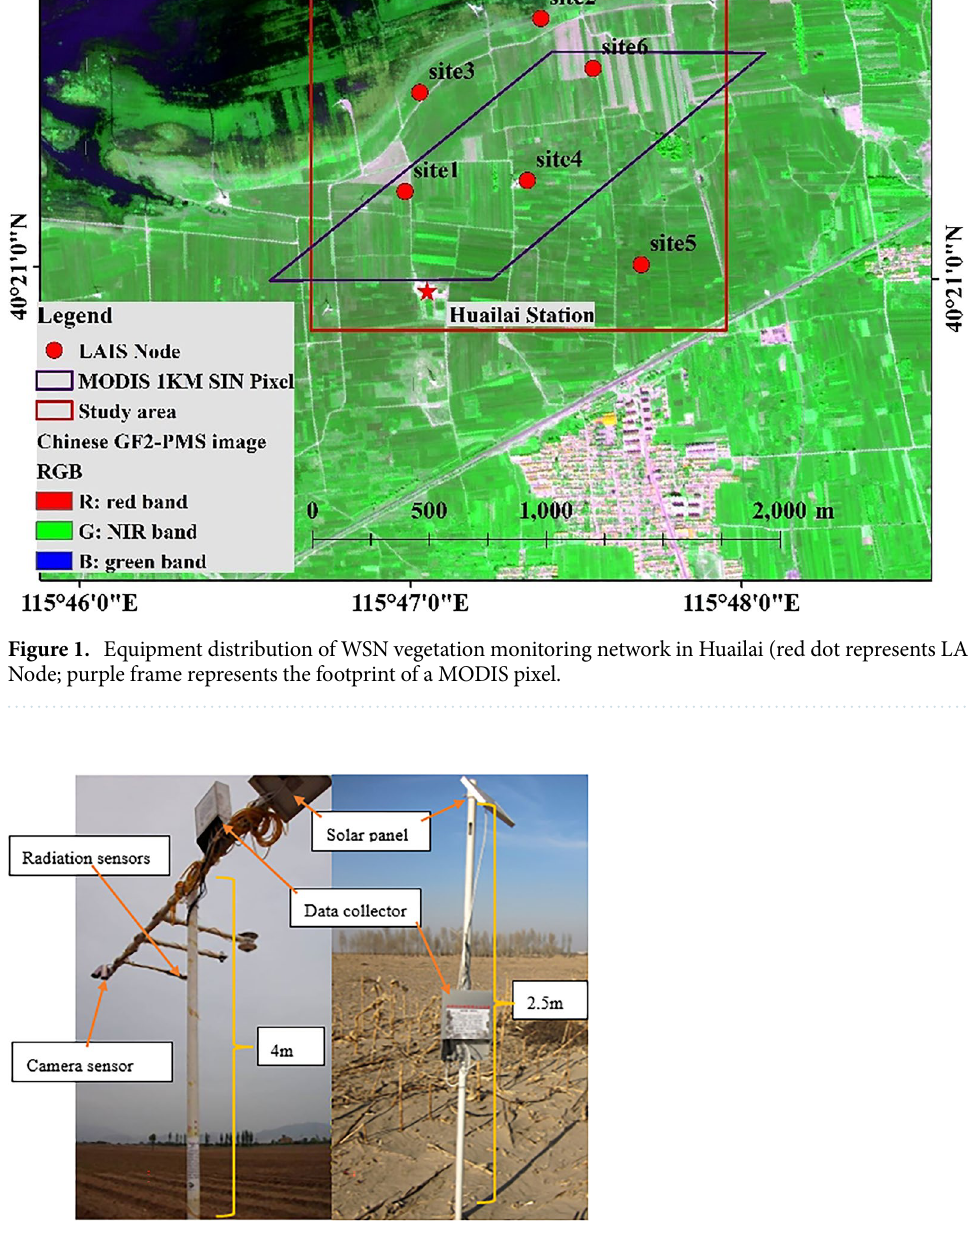
Figure 2. The design of the LAIS